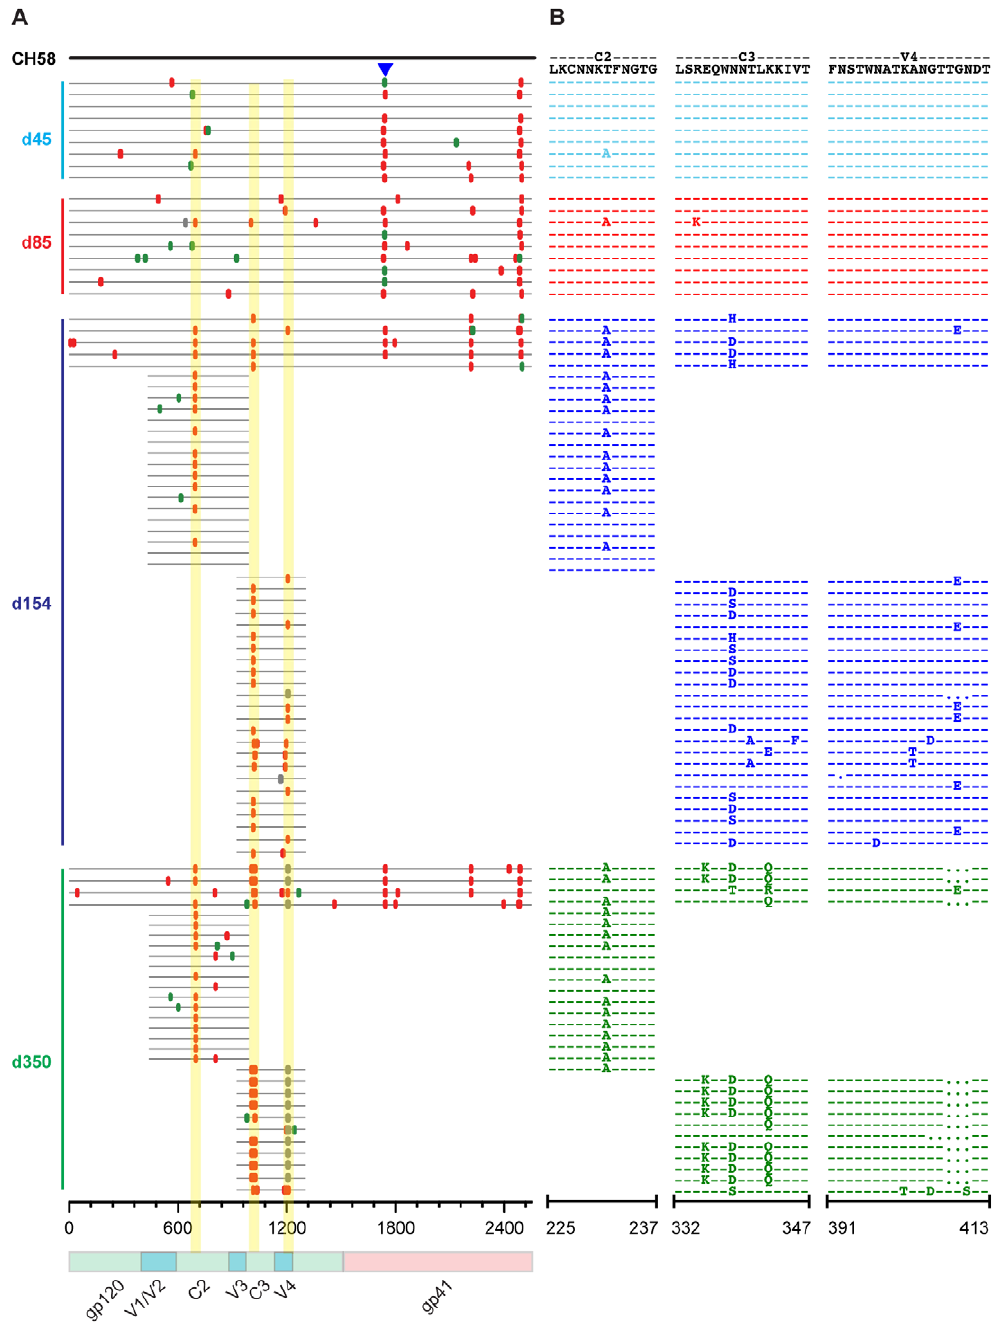
Figure 4. Highlighter analysis and env sequence alignments of putative Nab epitopes in subject CH58. A. Highlighter plots as described in Figure 2. B. Amino acid alignments of segments of the C2, C3, and V4 regions as described in Figure 2. SGA sequences were obtained from 12 independent experiments.